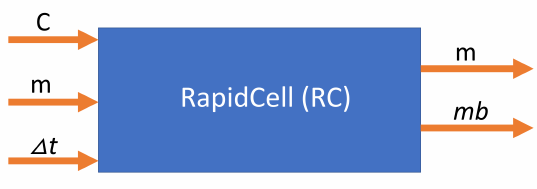
Figure 7. RapidCell model as a function of current concentration C, methylation m, and time interval ∆ t . The results are the updated methylation m and motor bias mb